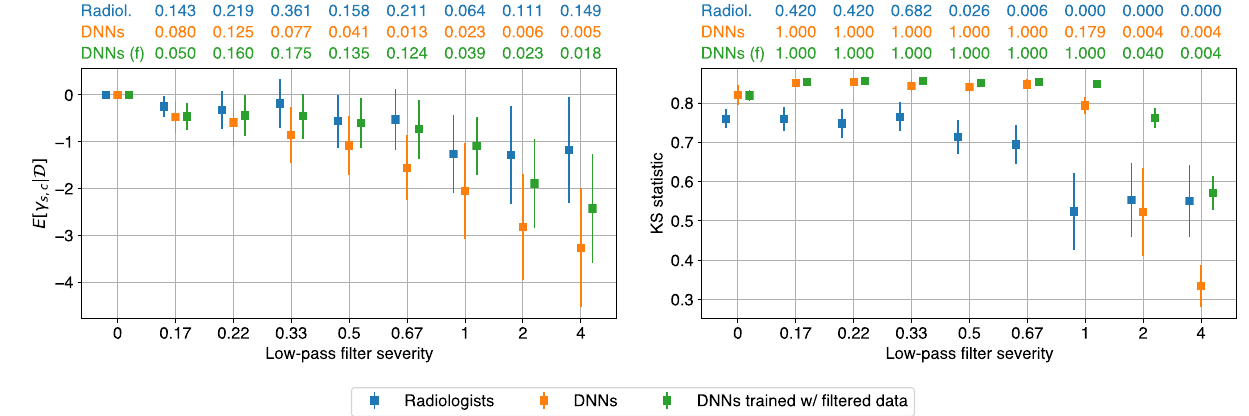
Figure 6. Simpson’s paradox leads to incorrect conclusions. If we merged microcalcifications and soft tissue lesions into a single subgroup, we would incorrectly conclude that radiologists and DNNs exhibit similar perturbation robustness both for predictive confidence (left) and for class separability (right). This highlights the importance of performing subgroup analysis when comparing human and machine perception. Figure created with drawio v13.9.0 https:// github. com/ jgraph/